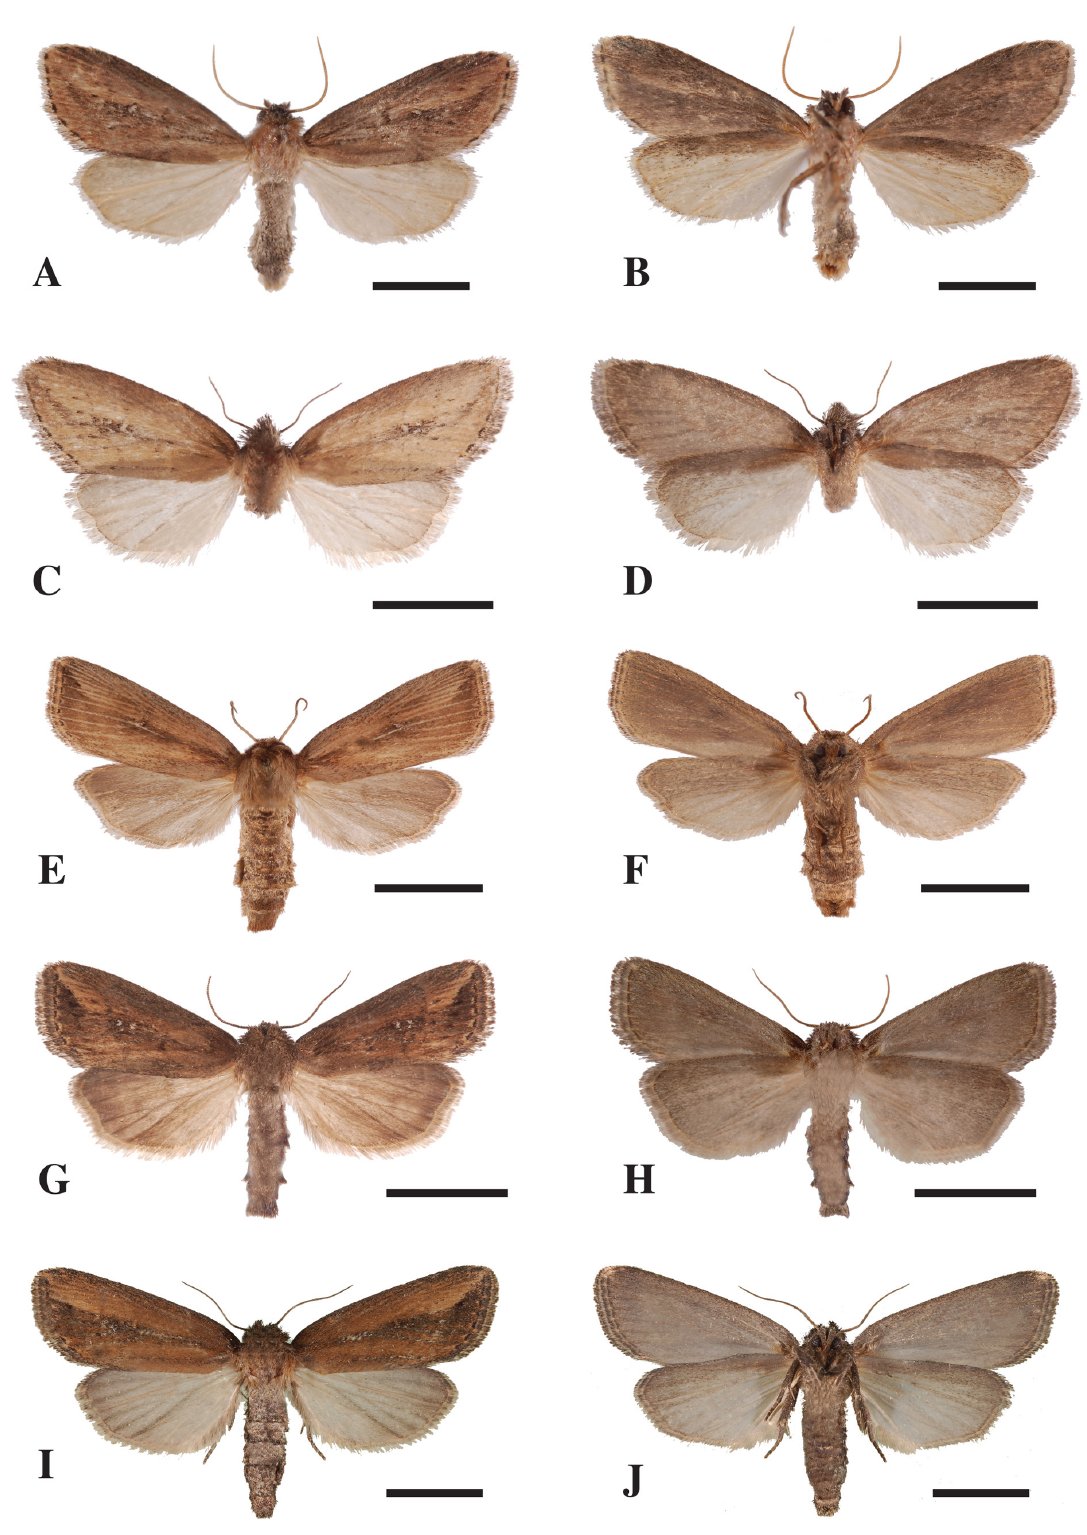
Fig. 8. Adults of species of Acrapex . – A–D . A. parvaclara Berio, 1973. A . ♂, upper side. B . ♂, under side. C . ♀, upper side. D . ♀, under side. – E–F . A. simillima le Ru sp. nov. E . ♀, upper side. F . ♀, under side. – G–J . A. unicolora (Hampson, 1910). G . ♂, upper side. H . ♂, under side. I . ♀, upper side. J . ♀, under side. Scale bars = 10